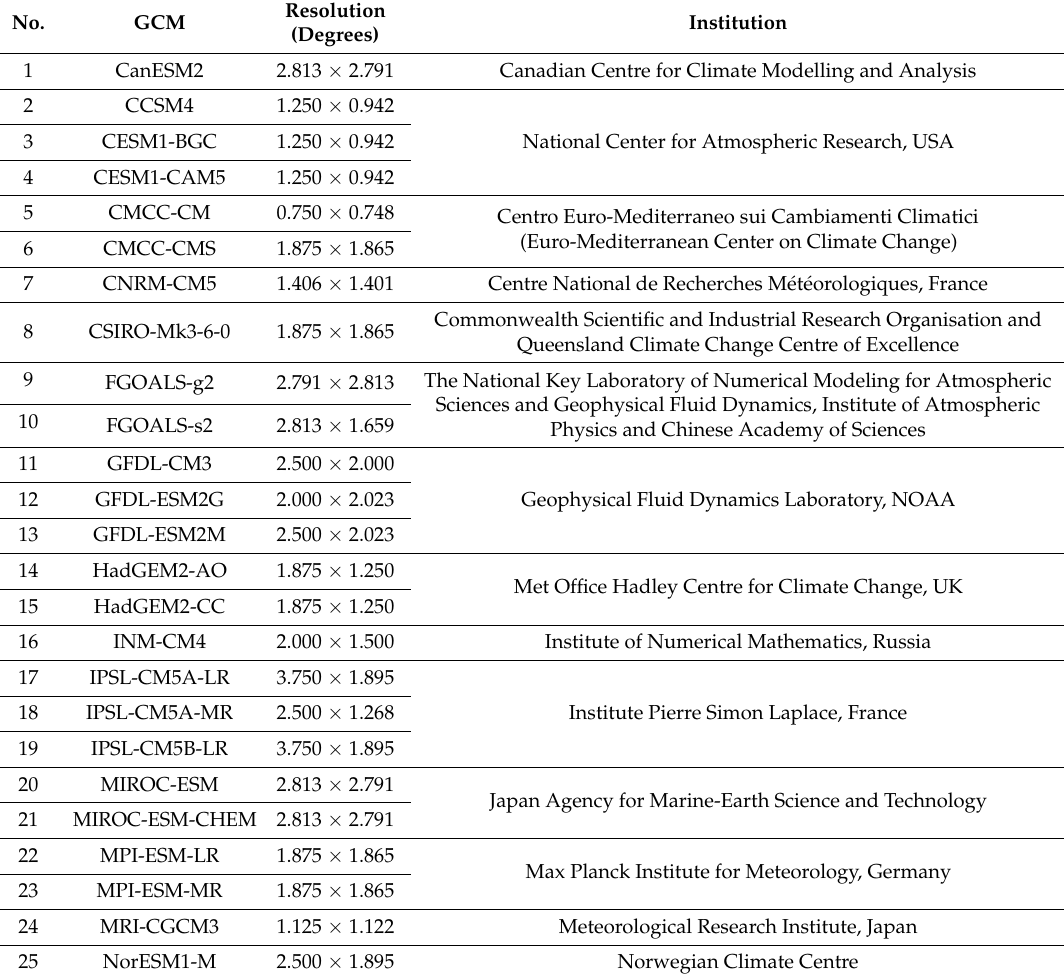
Table 1. The 25 GCMs of the Coupled Model Intercomparison Project Phase 5 (CMIP5) used in this